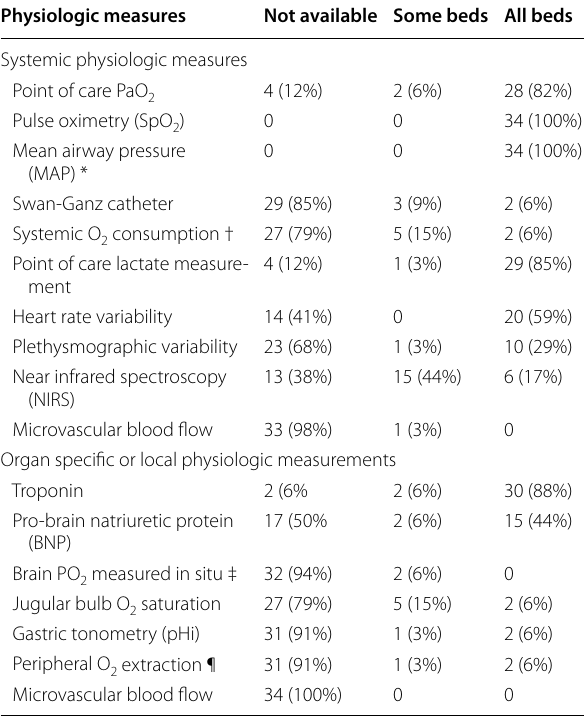
Table 1. Availability of physiologic measures for RBC transfusions in 34 PICUs Physiologic measures Not available Some beds All